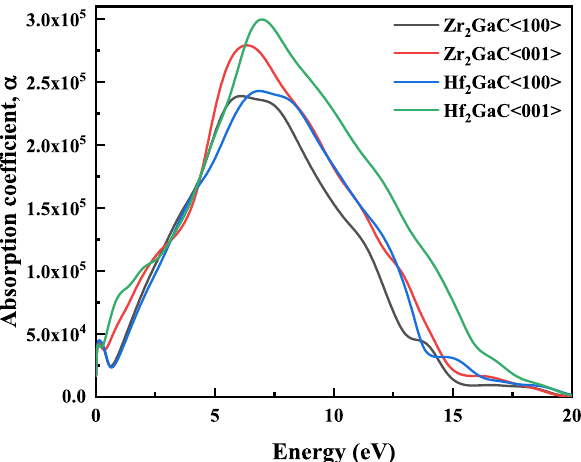
Figure 17. The optical absorption of M 2 GaC MAX phase (M = Zr, Hf) for <100> and <001> polarization.